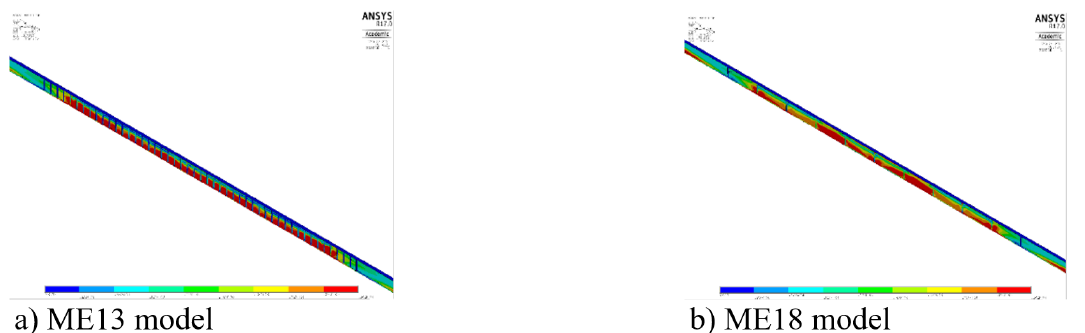
Figure 12. Von Mises stress in the steel profile of models ME13 and ME18.